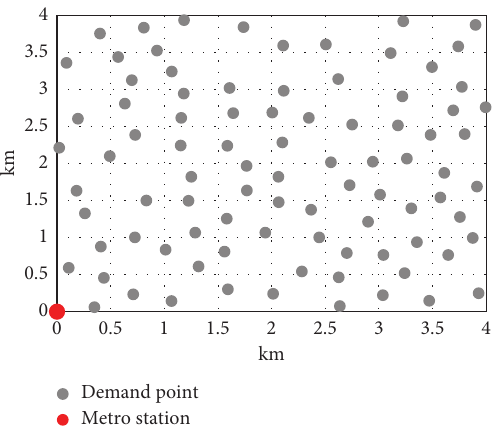
Figure 10: An example of the distribution of demand